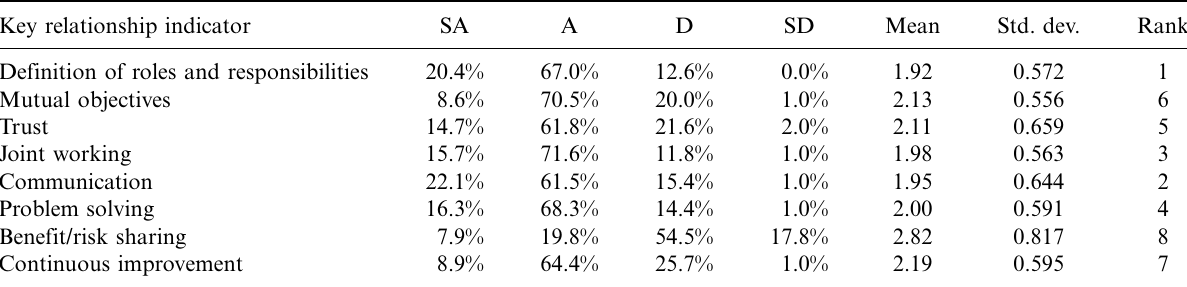
Table 2. Rating of key relationship indicators Key relationship